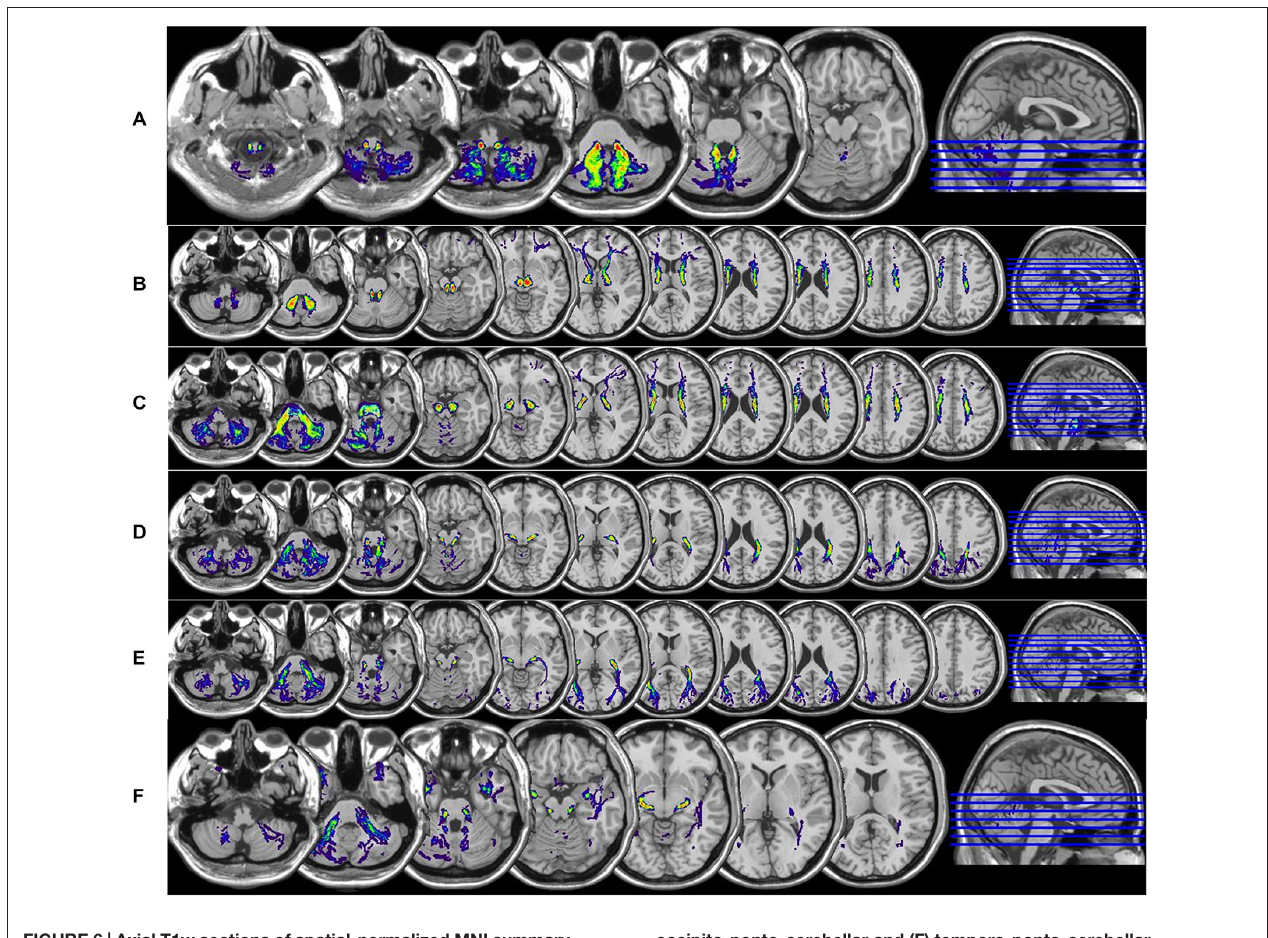
FIGURE 6 | Axial T1w sections of spatial-normalized MNI summary of (A) spinocerebellar tracts, (B) dentate-rubro-thalamo-cortical, (C) fronto-ponto-cerebellar, (D) parieto-ponto-cerebellar, (E)